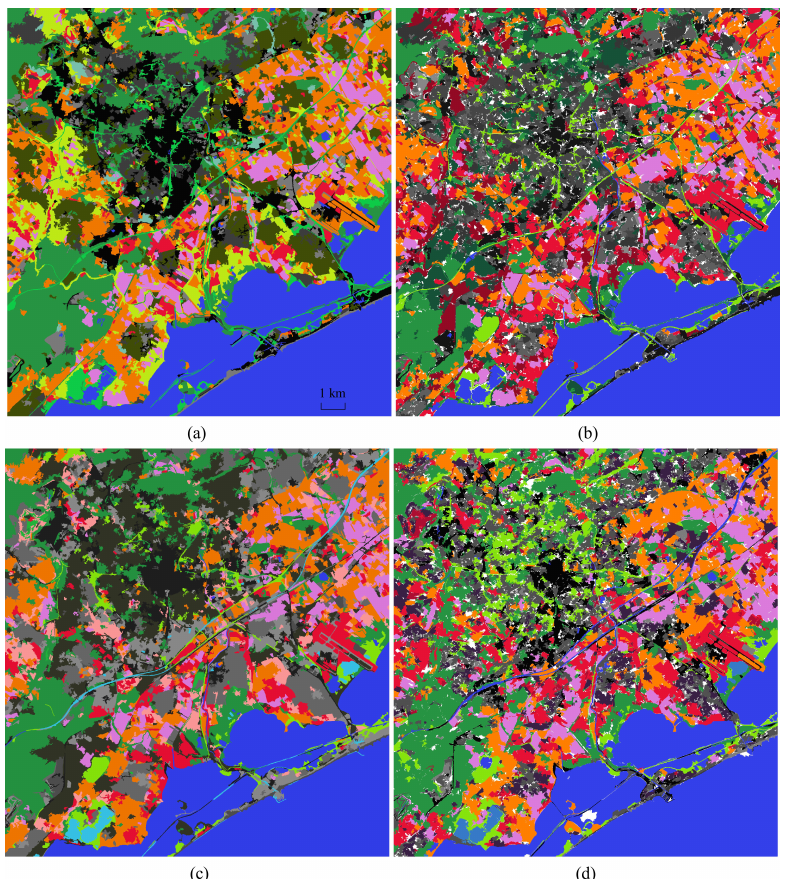
Figure 7. Clustering results for the concurrent approaches. ( a ) Object-based Dynamic Time Warping (DTW) for the SPOT-5 dataset, ( b ) Graph-based DTW for the SPOT-5 dataset, ( c ) Object-based DTW for the Sentinel-2 dataset, ( d ) Graph-based DTW for the Sentinel-2 dataset. For the legend, please, refer to Figure 5. The clusters are colored accordingly to the GT maps, if one class is presented by several clusters, these clusters are colored in different shades of the referent class color. For graph-based DTW white pixels correspond to the areas that are not covered by